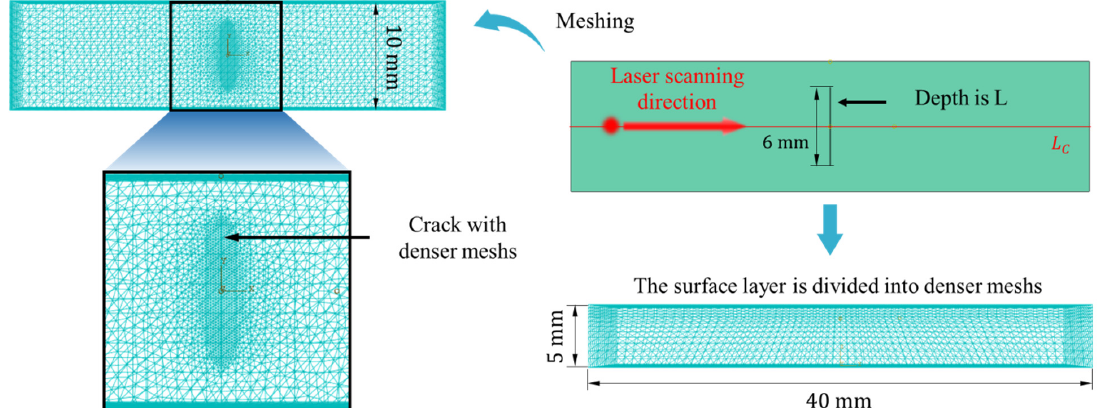
Figure 4. Geometry and meshing of the simulation